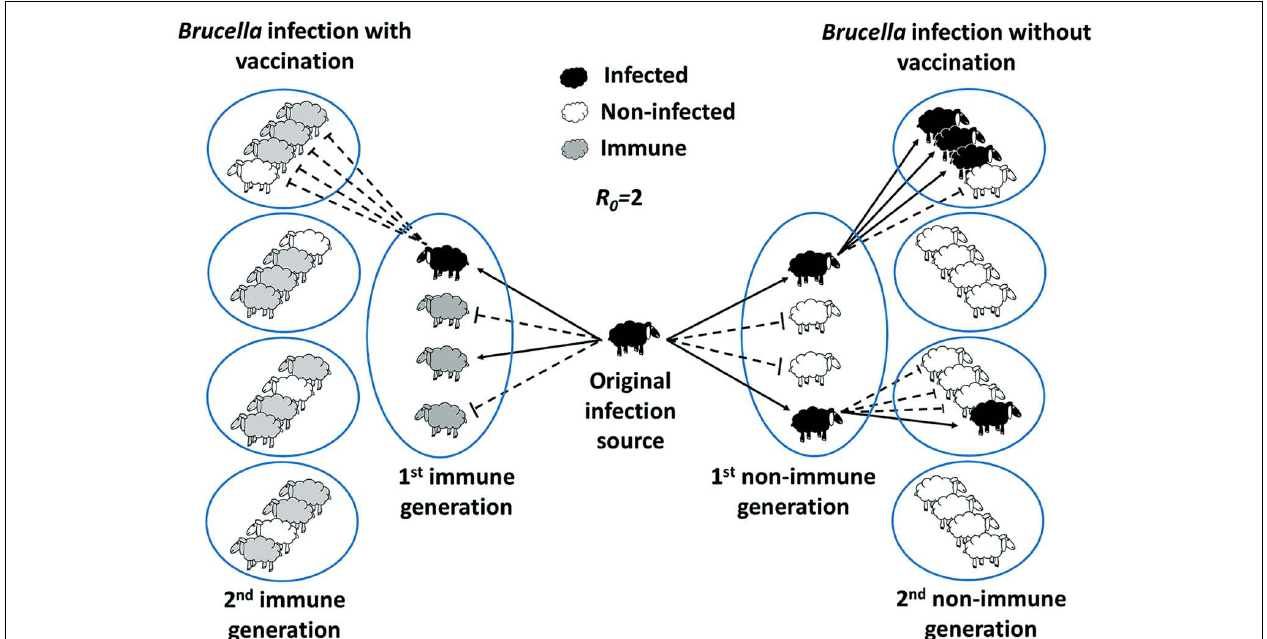
population (predicted on the basis of R 0 ) are immune to the bacterium. For instance, if R 0 = 2 (an estimated R 0 for B. melitensis transmission in sheep), then a geometric increase in infections occurs over time (right panel). If 75% of the population is protected by the vaccine (minimal protection rate estimated for Rev1 vaccine), then the bacteria fails to grow in the host animal and be transmitted (left panel). It is predicted that vaccines with lower protection rate require larger coverture and greater actions of culling of the animals. New productive infections are depicted by black solid arrows; unproductive transmission is indicated by dashed blunt